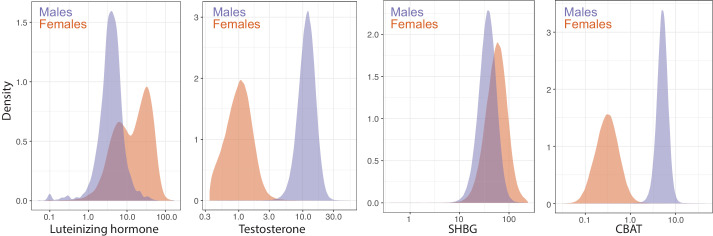
Distributions of female and male luteinizing hormone, testosterone, sex hormone binding globulin (SHBG), and calculated bioavailable testosterone (CBAT) levels in the UK Biobank.Luteinizing hormone is from primary care records (Materials and methods), while Testosterone, SHBG, and CBAT are measured or derived from the baseline assessment center visit.